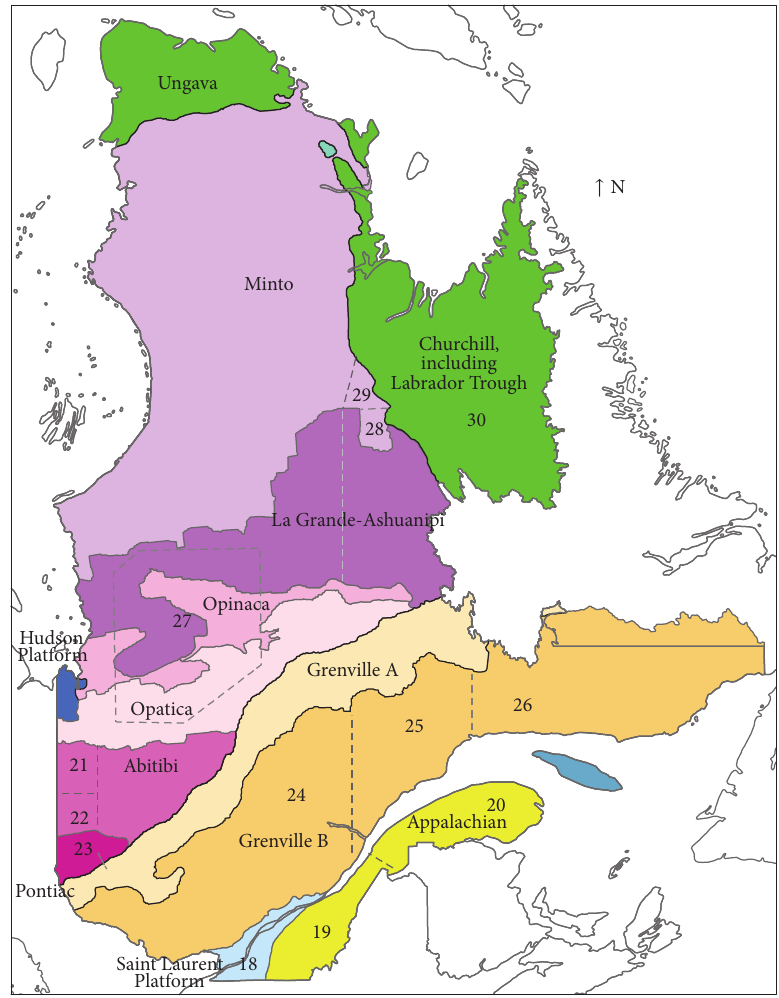
Figure 12: Sediment survey zones 19 to 30 overlaid on the geological provinces of Quebec, adapted from https://www.mern.gouv.qc.ca/ english/publications/mines/publications/geological-domains-quebec.pdf